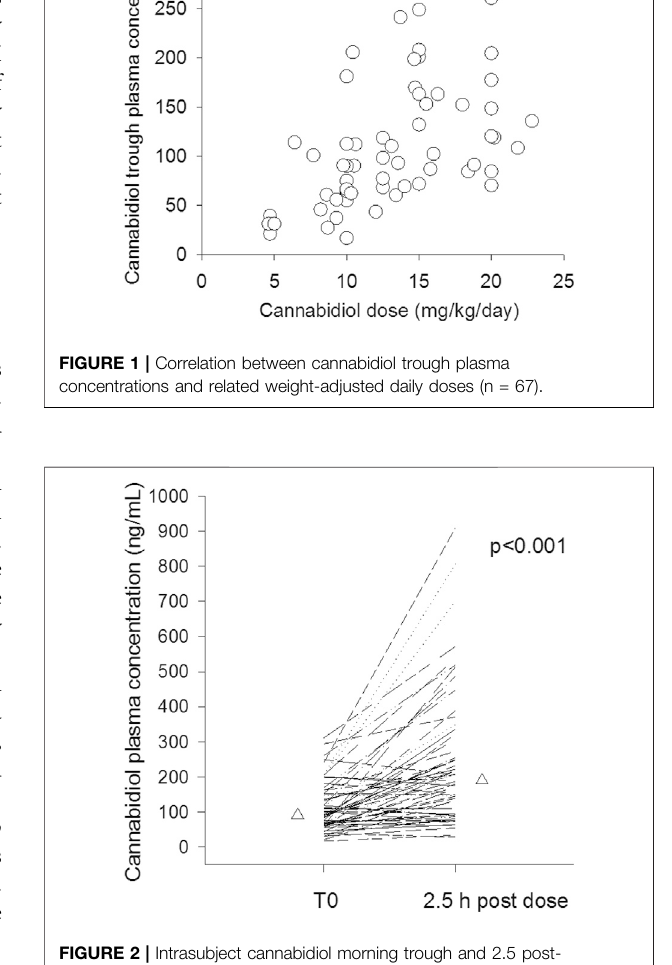
FIGURE 2 | Intrasubject cannabidiol morning trough and 2.5 post- dosing plasma concentrations of cannabidiol (n (cid:1) 60). Median values are represented by